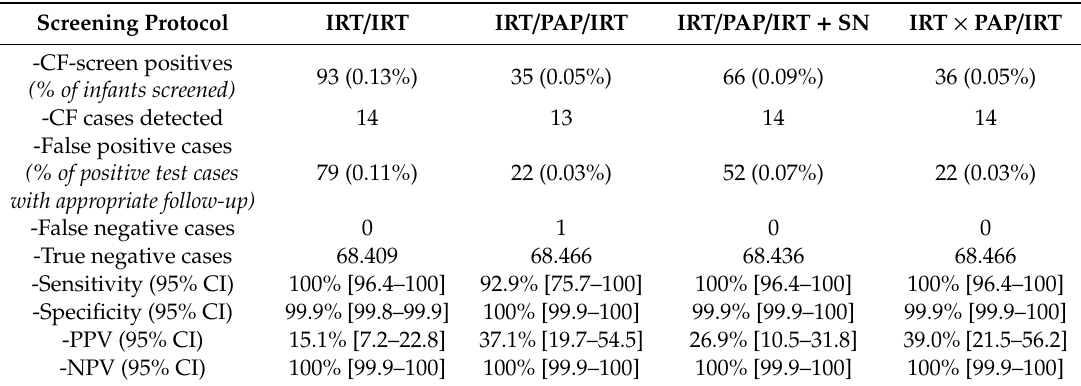
Table 2. Performance of four di ff erent CF-NBS protocols for 68,502 newborns screened and 14 infants with CF detected during the pilot